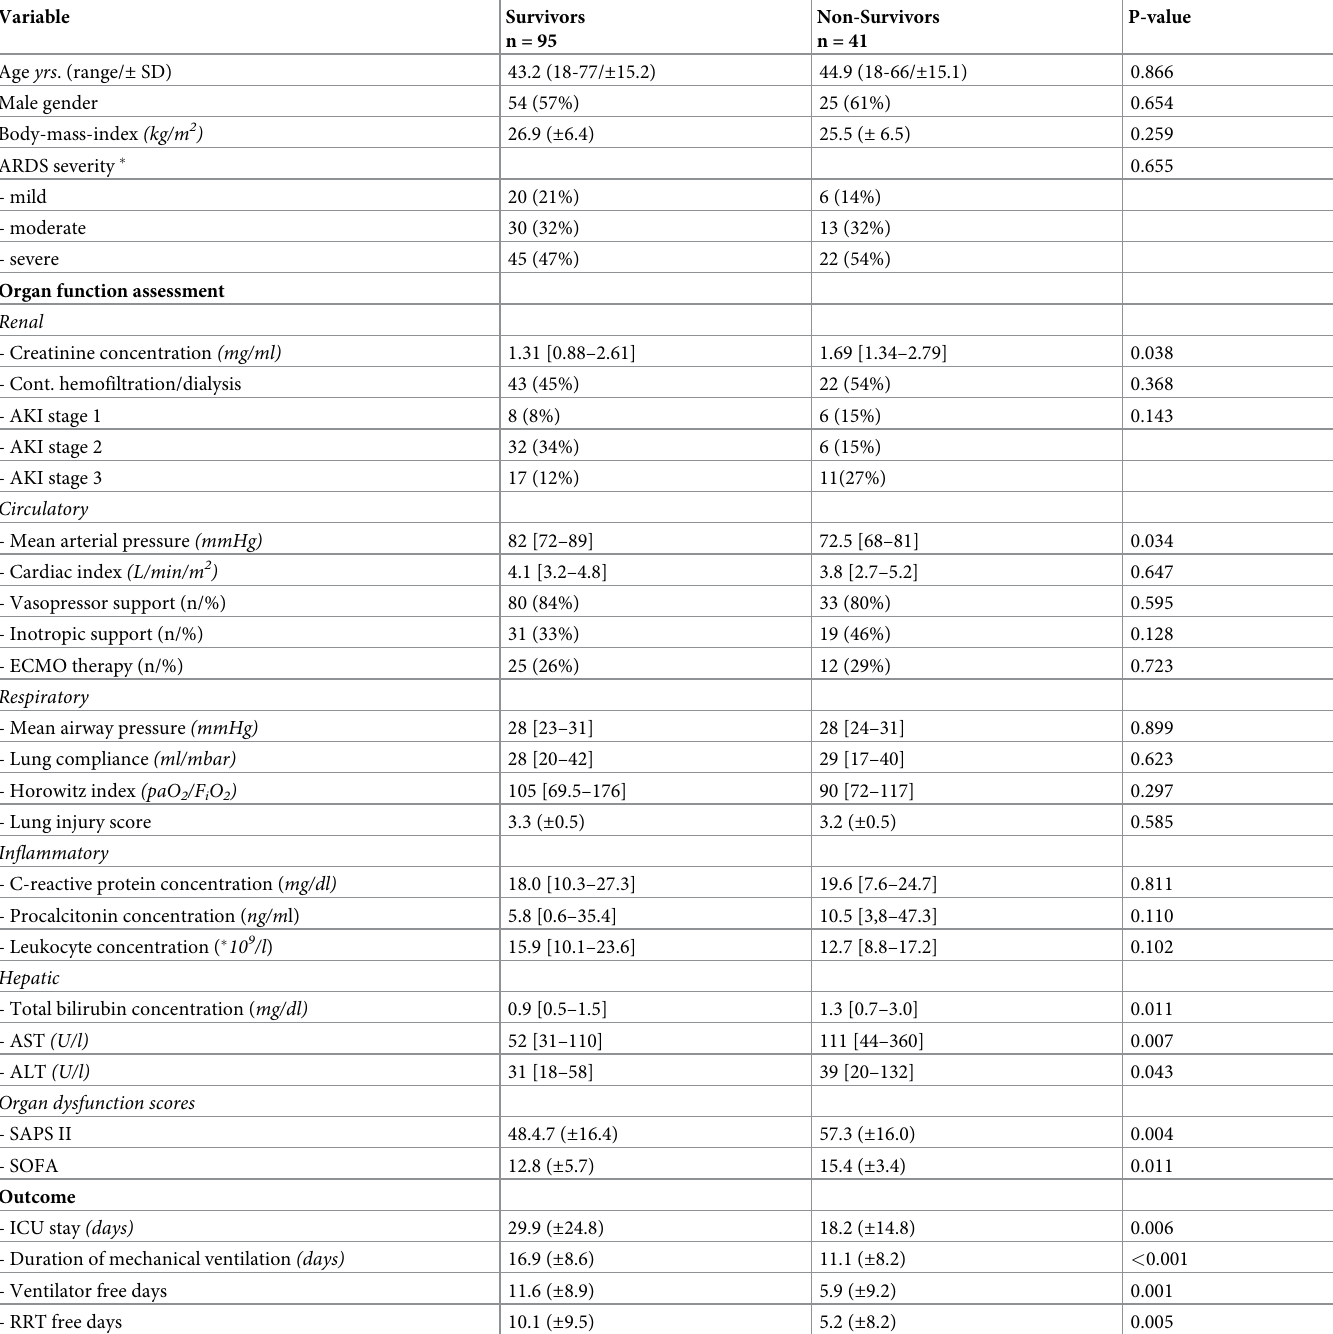
Table 2. Baseline characteristics upon ICU admission of patients with pneumonia evoked ARDS as stratified for 30-day survival and non-survival (n =